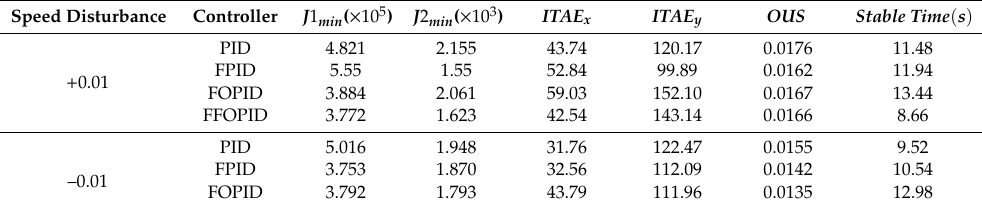
Figure 11. Comparison of speed curves by different controllers.